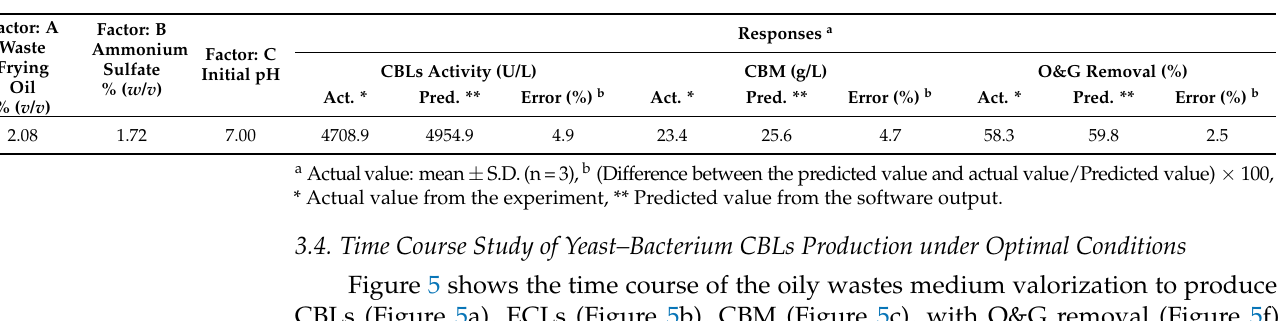
Table 5. The best solution for operational conditions. The conditions were obtained from the software to confirm optimization capability by the co-culture of M. spicifer AW2 and S. hominis